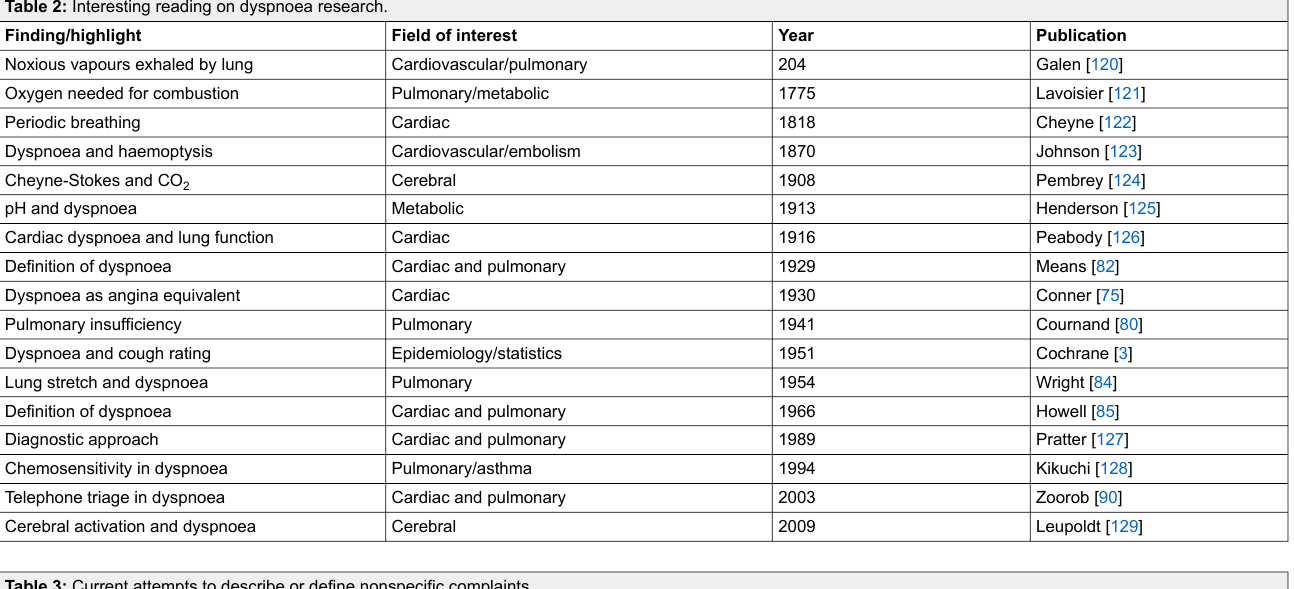
Table 3: Current attempts to describe or define nonspecific